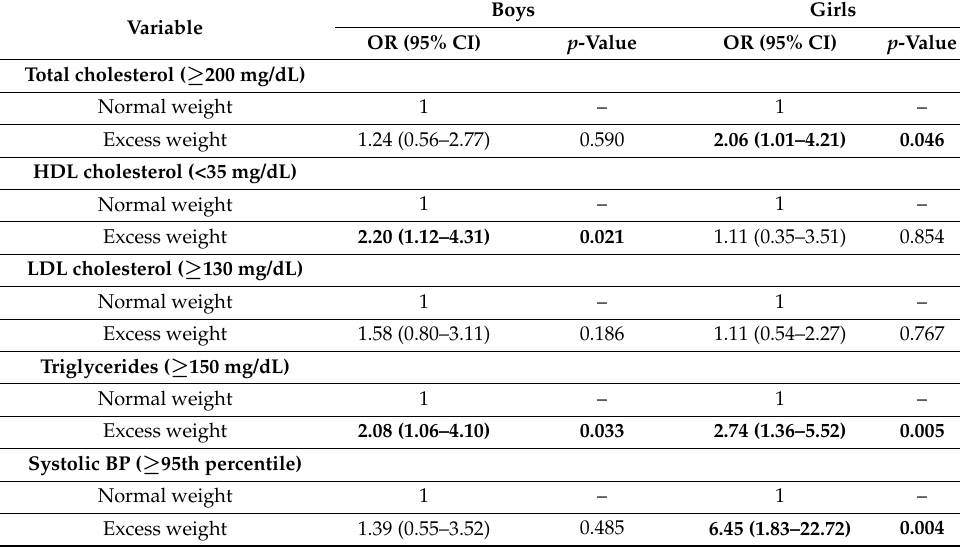
Table 4. Odds ratios for cardiovascular risk factors in children with excess body